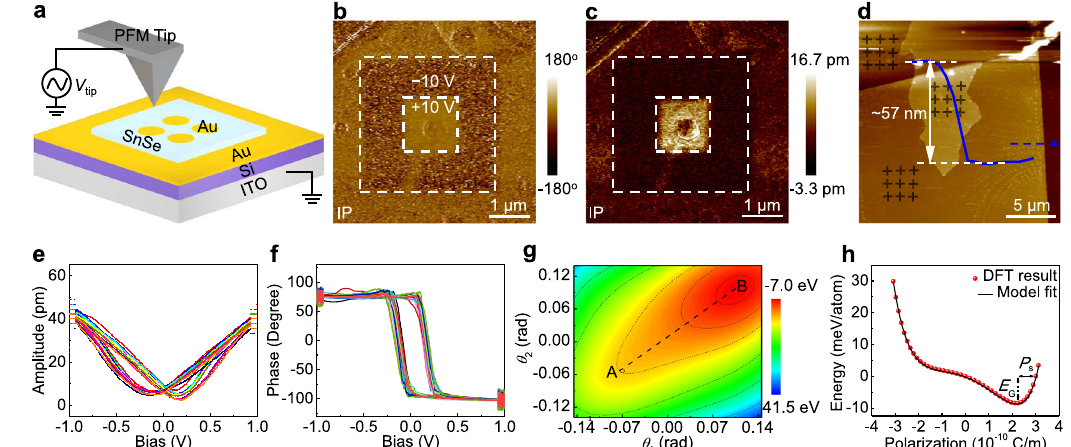
Fig. 5 | The ferroelectricity determination of 2D p-doped SnSe. a Schematic diagramofthePFMmeasurement. b , c Phaseandamplitudeimagesof2Dp-doped SnSe after poling with ±10V, showing stable polarization states. d AFM image and corresponding height pro fi le analysis of a 57-nm-thick tetragonal SnSe nanosheet with a top Au electrode. e , f Corresponding PFM amplitude hysteresis loops and